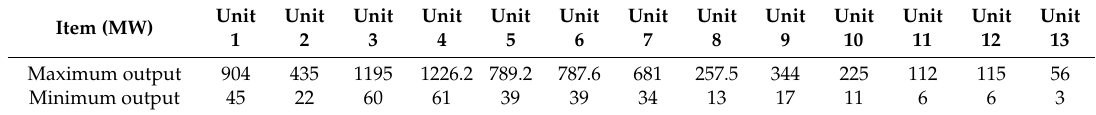
Table 2. Basic information of the gas-fired generating units in Zhejiang provincial electric system.